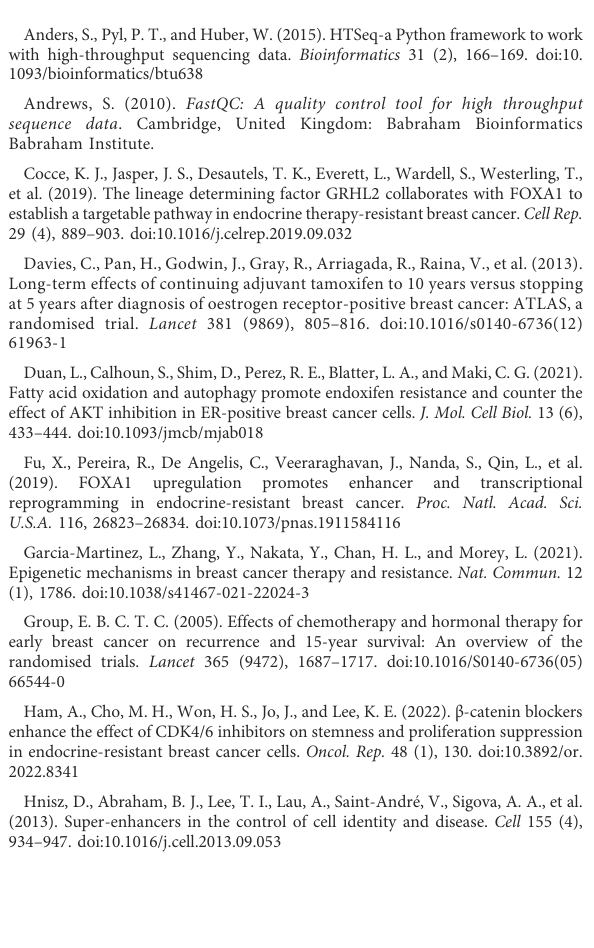
Potential function of FOXA1 and H3K27ac in MCF7/TamR. BETA analysis of the FOXA1 (A) and H3K27ac (B) binding and expression data sets from MCF7/TamR cells. Red line represents up-regulated genes, purple line represents down-regulated genes, and dashed line represents the non- differentially-expressed genes as background.